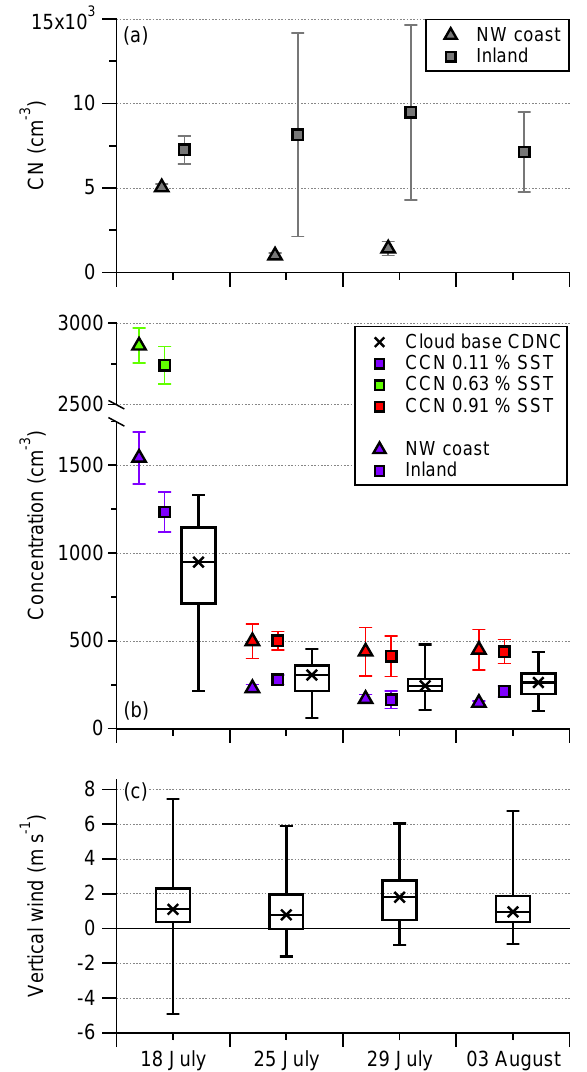
Figure 8. Comparison of particle concentrations measured in ma- rine air (triangles) and inland (squares). Panel (a) shows the CN concentrations, while (b) compares the CCN concentrations to the CDNC measured in updraughts > 2ms − 1 within 500m of cloud base. The boxes and whiskers show the 25/75th percentiles and the maximum/minimum. Panel (c) shows the distribution of verti- cal wind in cloud penetrations (liquid water content > 0.01gm − 3 ) within 500m of cloud